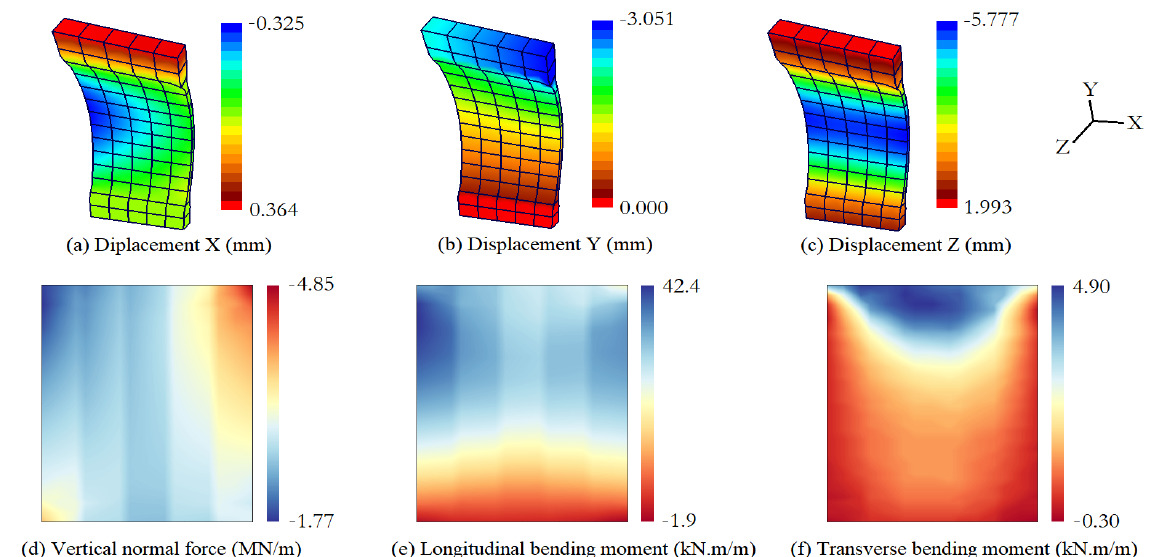
Figure 13. Simple planar shear wall displacements and internal forces diagrams, λ = 90